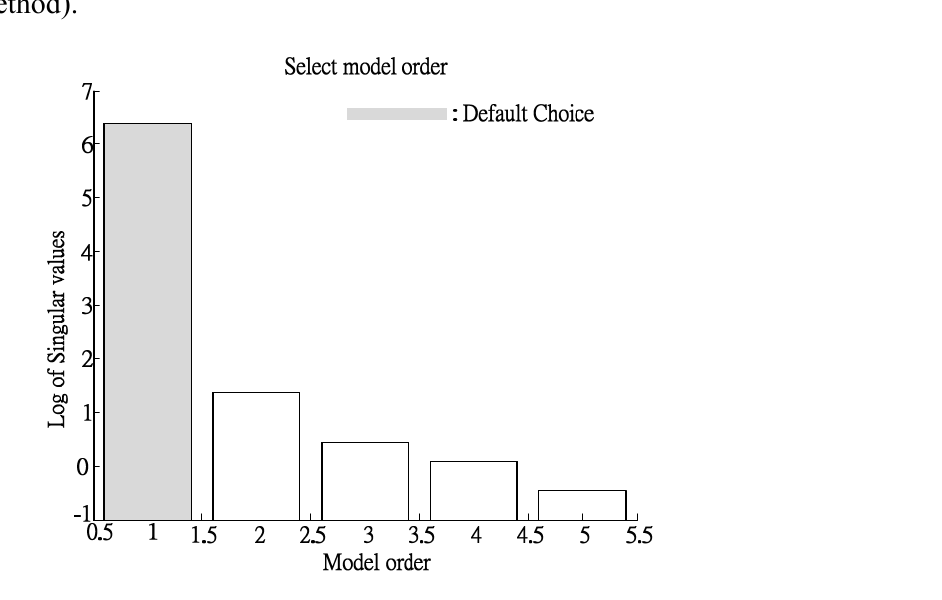
Figure 9. Order of optimal noise model using 4SID (SubSpace-base State Space Model Identification Method).